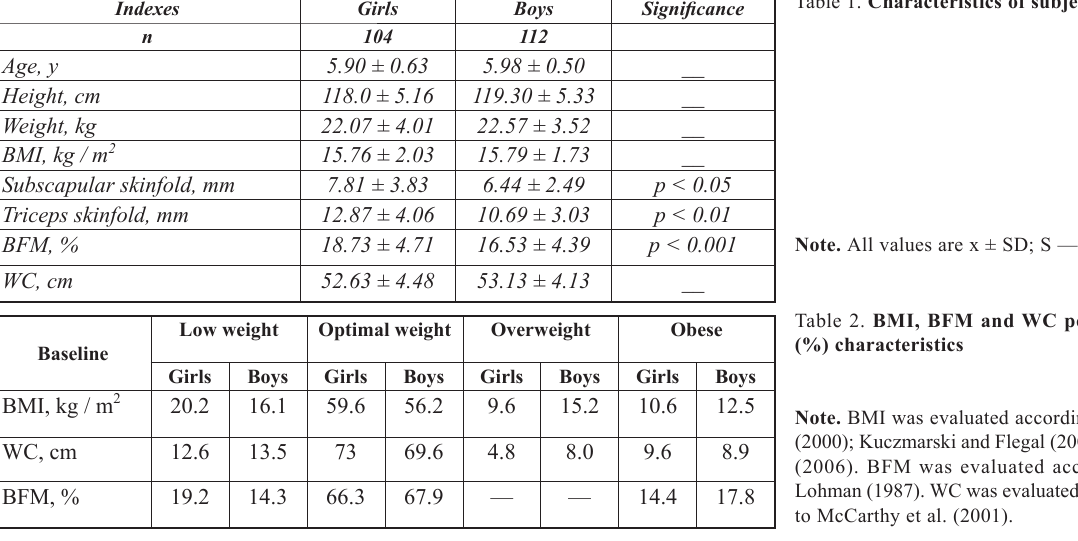
Table 2. BMI, BFM and WC percentage (%) characteristics